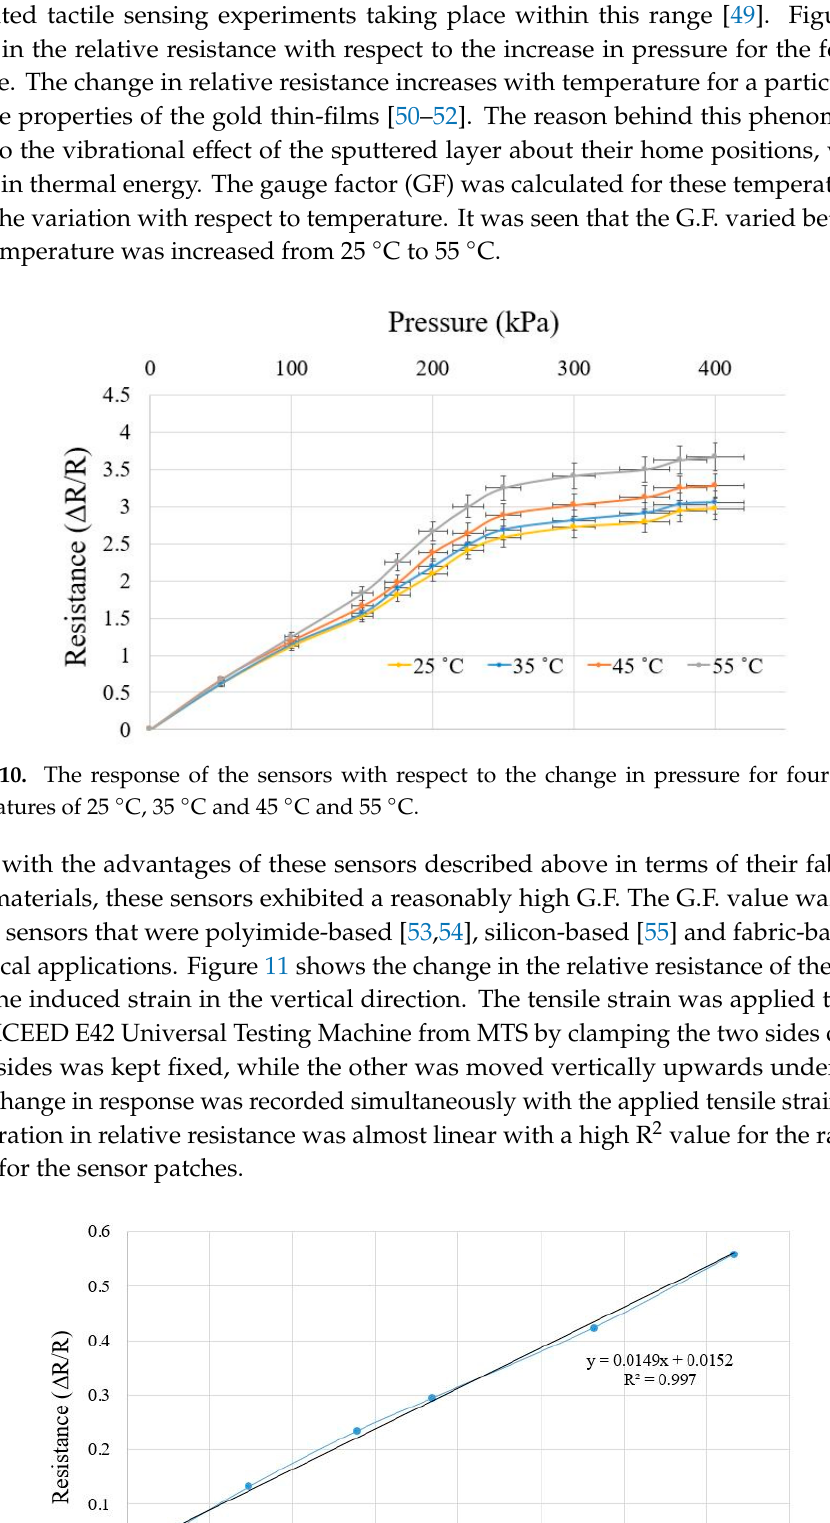
Figure 11. The response of the sensors in terms of change in relative resistance for the applied strain.